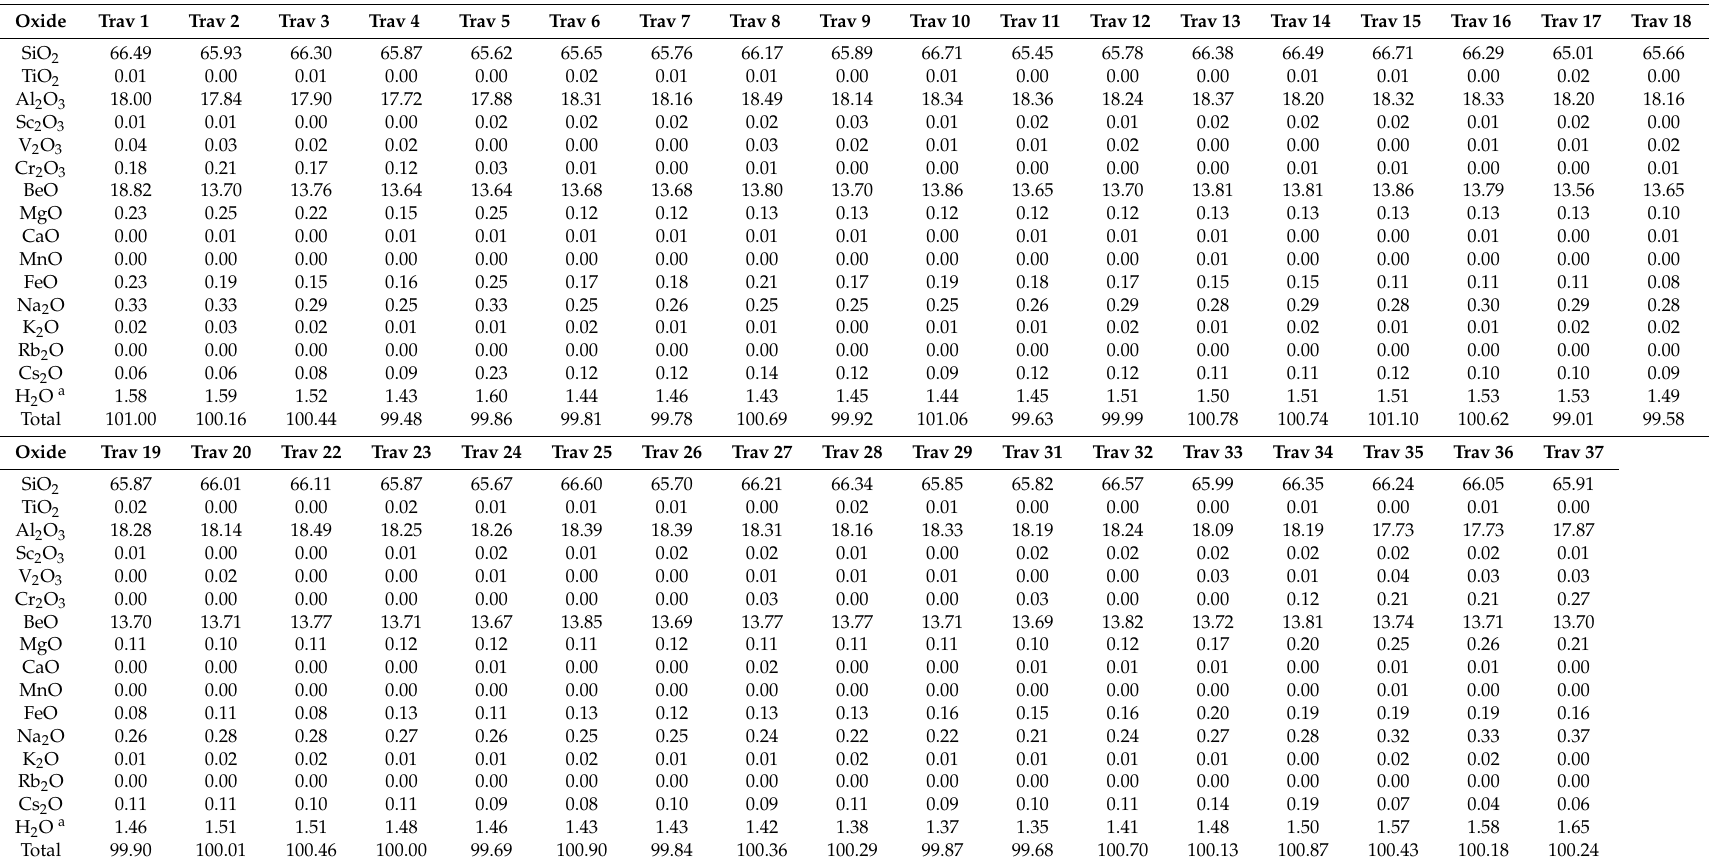
Table 1. Weight percent oxide values from Electron microprobe analyses + of the Poona emerald along traverse line indicated in Figure